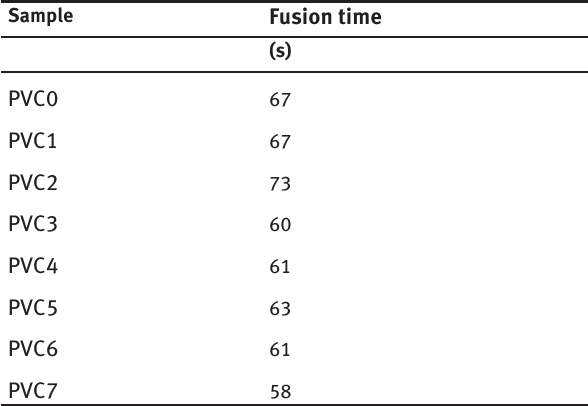
Table 4: Fusion time values of plain PVC and the flame retardant composites.